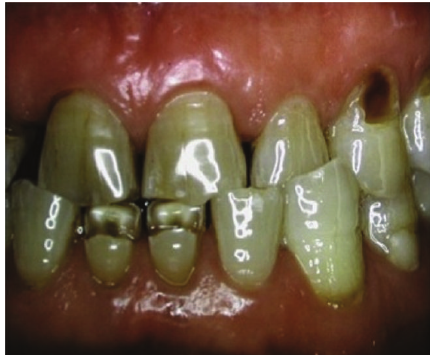
Figure 8: Two wedge-shaped lesions have formed on the lower first central incisors. To date there is no definite explanation as to the cause of the wear